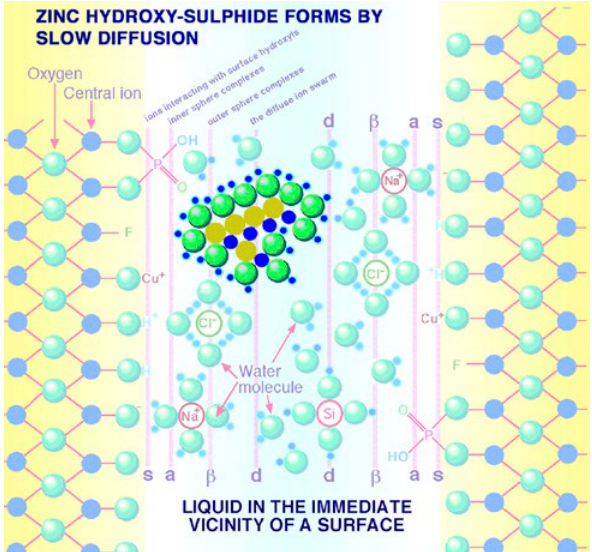
Figure 75. The initial solid phase of zinc sulphide precipitate is too small to be seen by SEM. In this diagram it is depicted as a hydrat- ed nucleus surrounded by adsorbed water molecules. The oxygen atoms in this surface water are two hydrogen atoms short of those required to hydrate the cluster entirely with water molecules. The actual atomic geometry and hydration of a molecular cluster of this nature is quite difficult to determine and it is probably variable. It is quite important that some of the water molecules are dissociated. Hydroxyl groups have reacted with some or all of the high-energy lattice